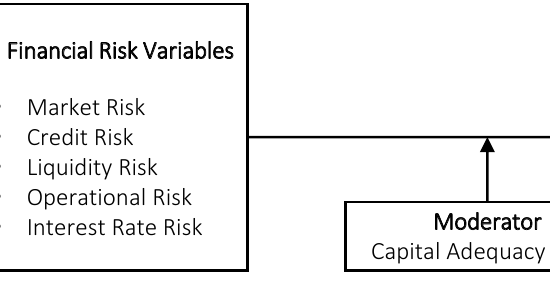
Figure 1. Logical relationship between variables